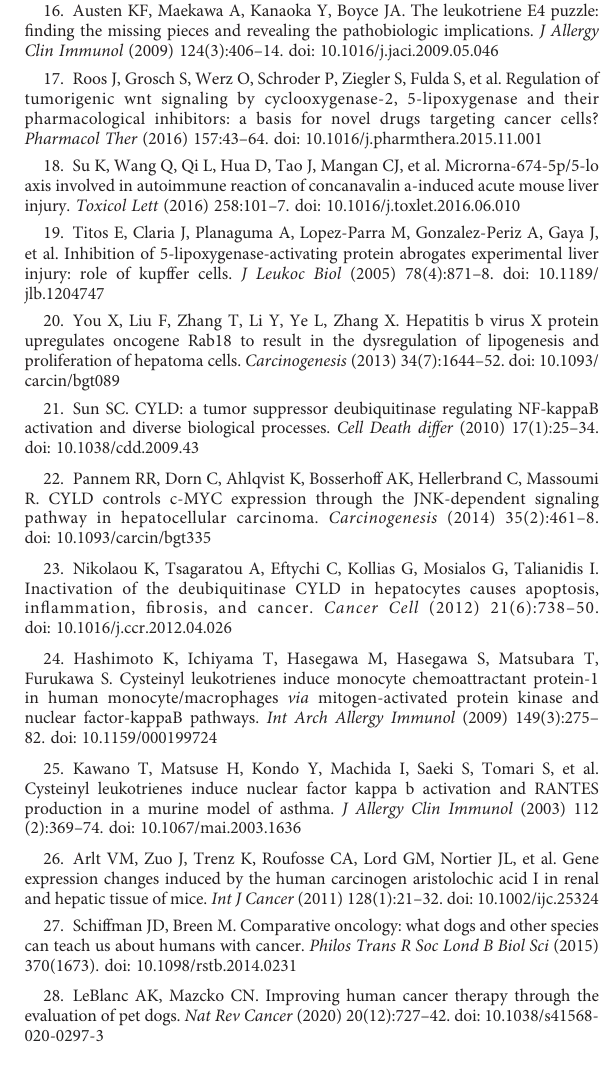
SUPPLEMENTARY FIGURE 6 Overexpression of FLAP diminishes CYLD expression in AAI-treated Hep3B lv- FLAP cells. WT HCC cells without AAI treatment were used as control. In the case of AAI treatment, representative photomicrographs of CYLD abundance (red: distribution in cytoplasm, blue: nuclei with DAPI staining) was indicated by immuno fl uorescence histochemistry. Bar=100 m m, bar=20 m m (magni fi